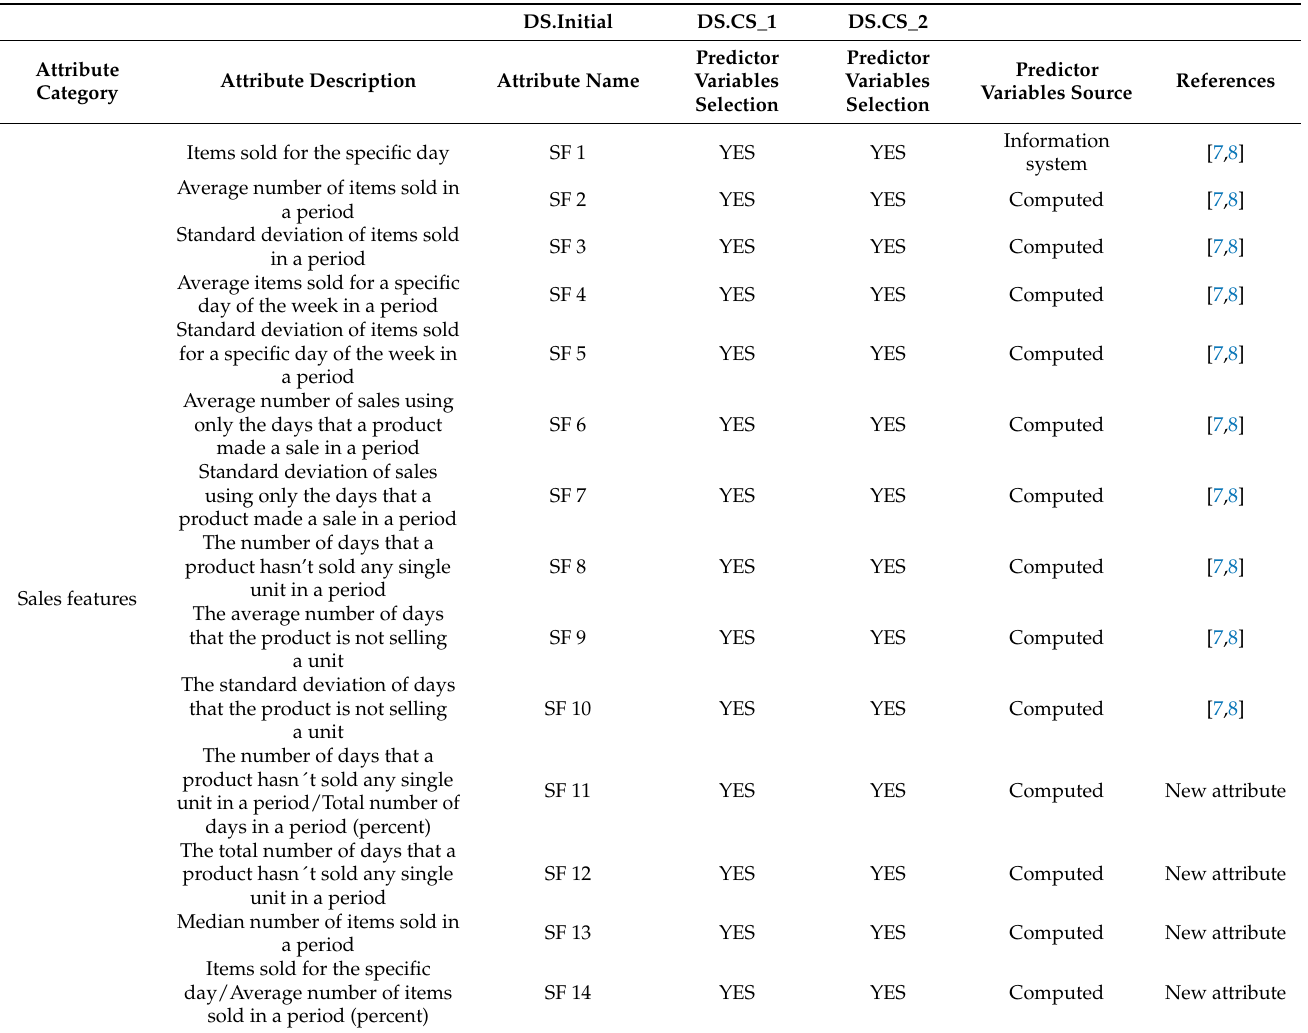
Table 1. Predictor variables definition, selection, and dataset